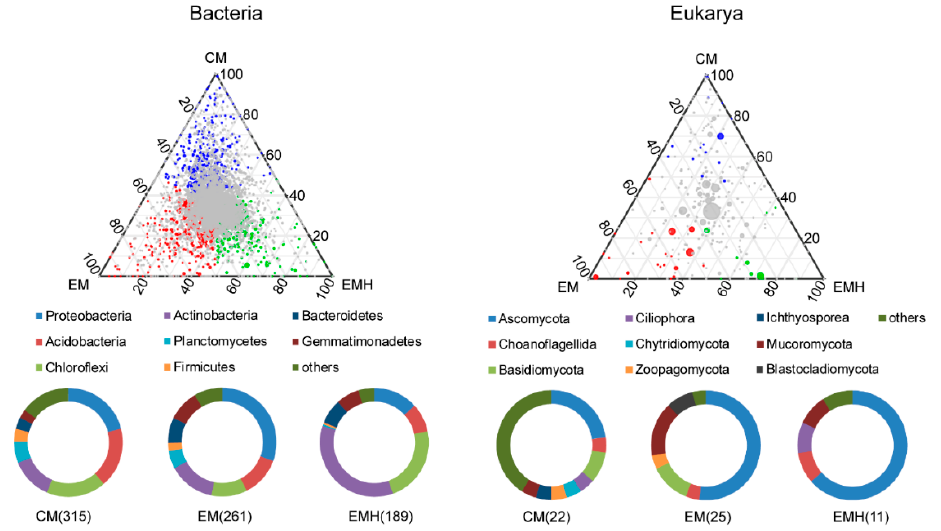
Figure 4. Ternary plots showing the enriched bacterial and eukaryotic amplicon sequence variants (ASVs) in the three farming systems.